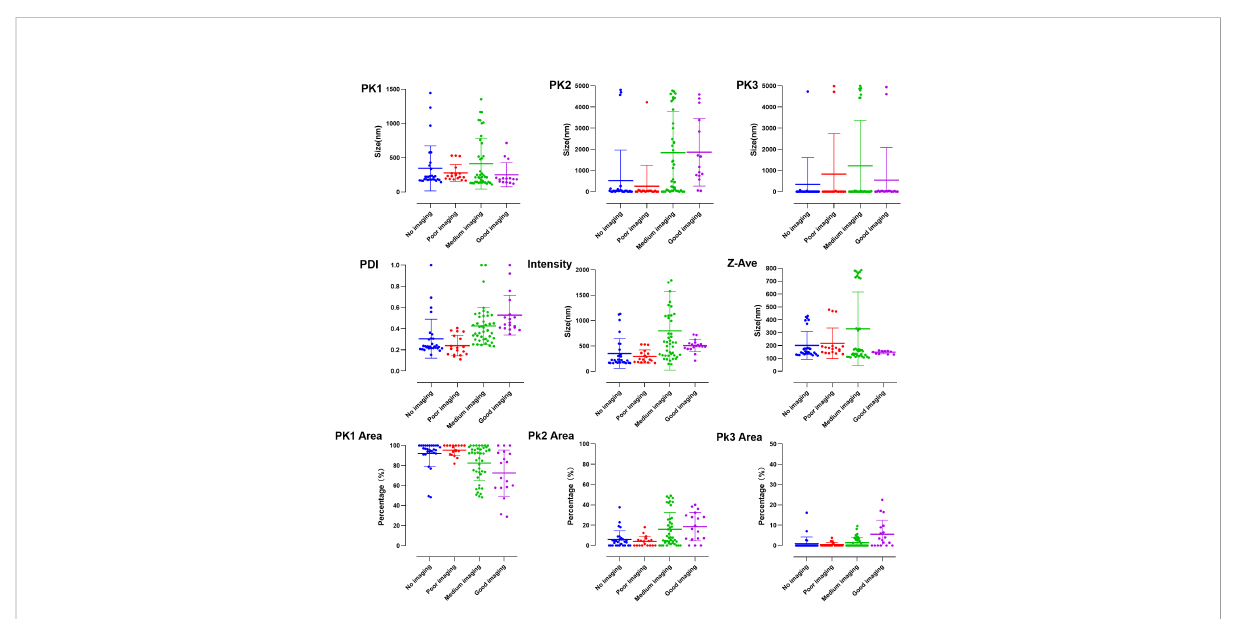
FIGURE 4 Visualization of particle size data incorporated into the initial conditions of the neural network model.